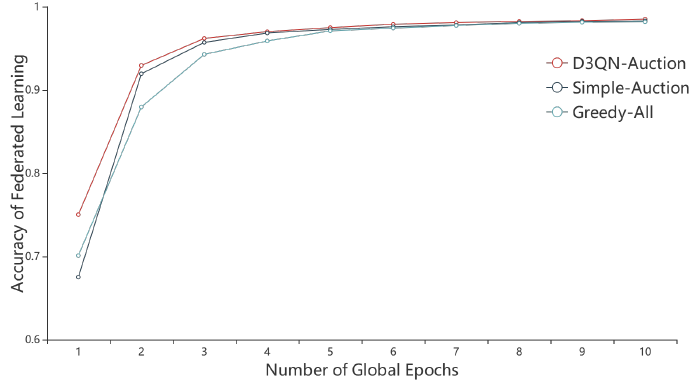
Figure 7. The comparison of the accuracy rates of the three